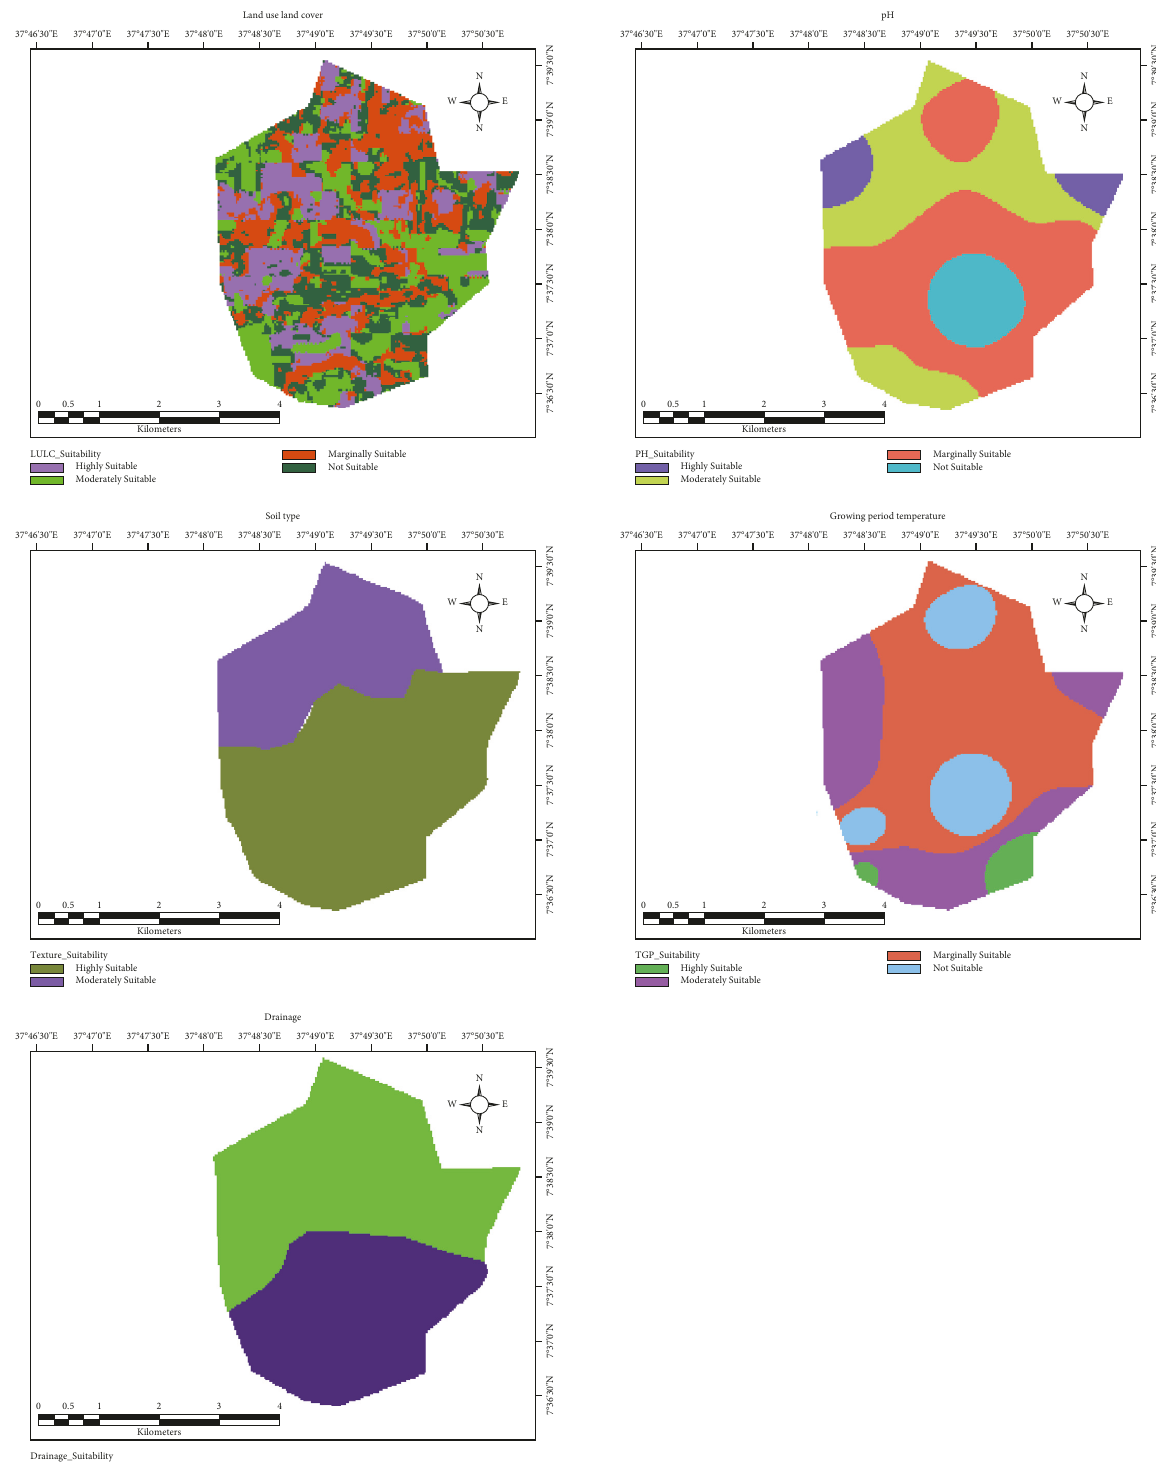
Figure 3: Suitability maps of